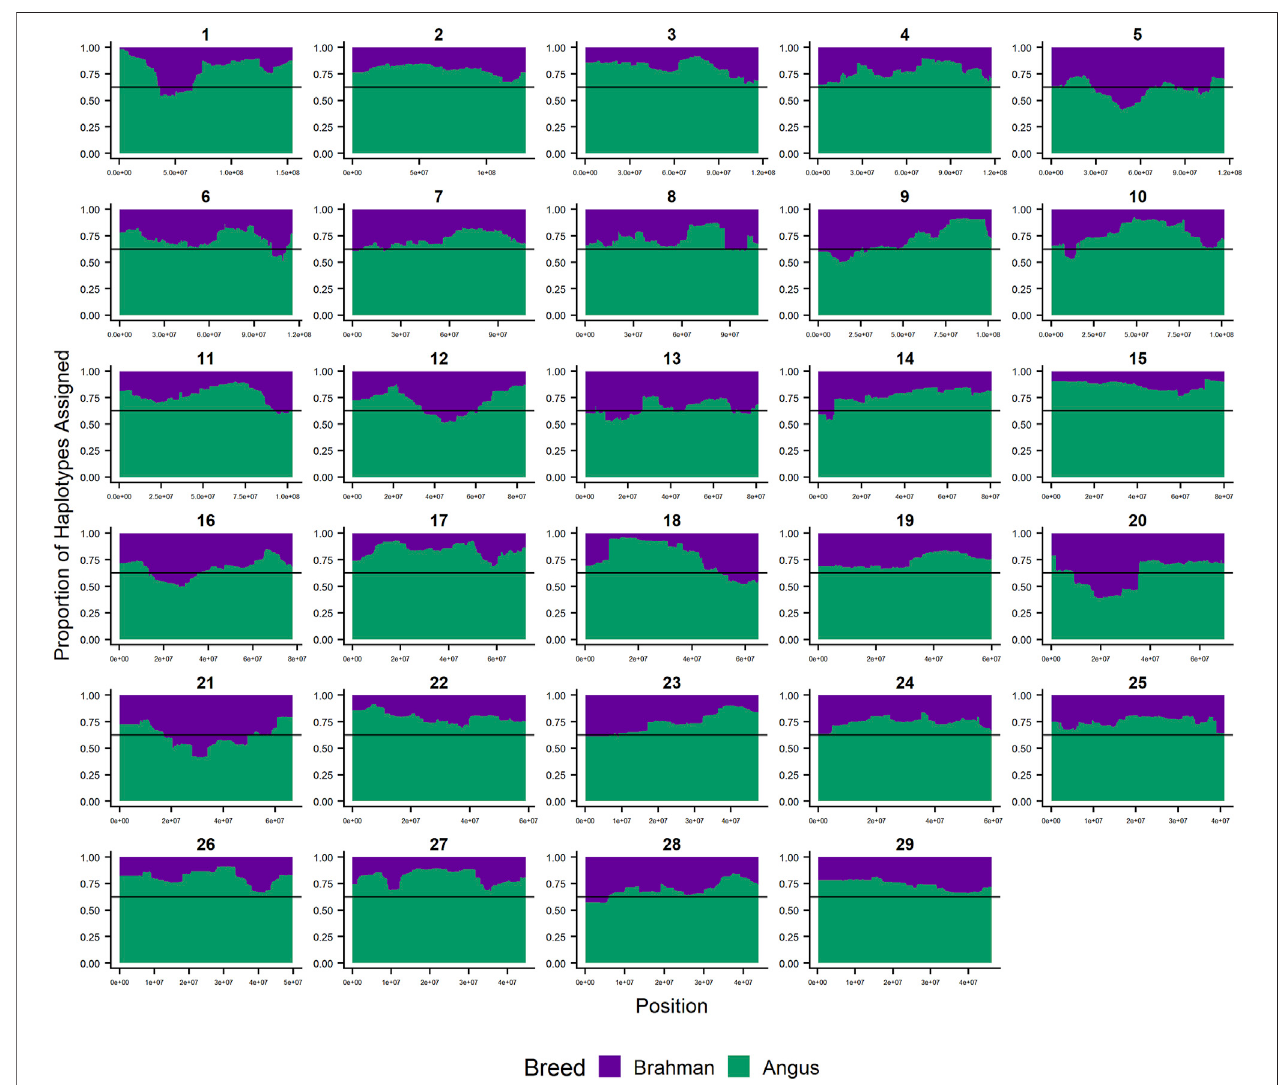
FIGURE 1 | RFMix most likely assignment by chromosome for the ANCESTRAL reference panel for each 25 SNP window for Brangus. Brahman (purple) and Angus (green). Horizontal line indicates 5/8 expected Angus proportion.